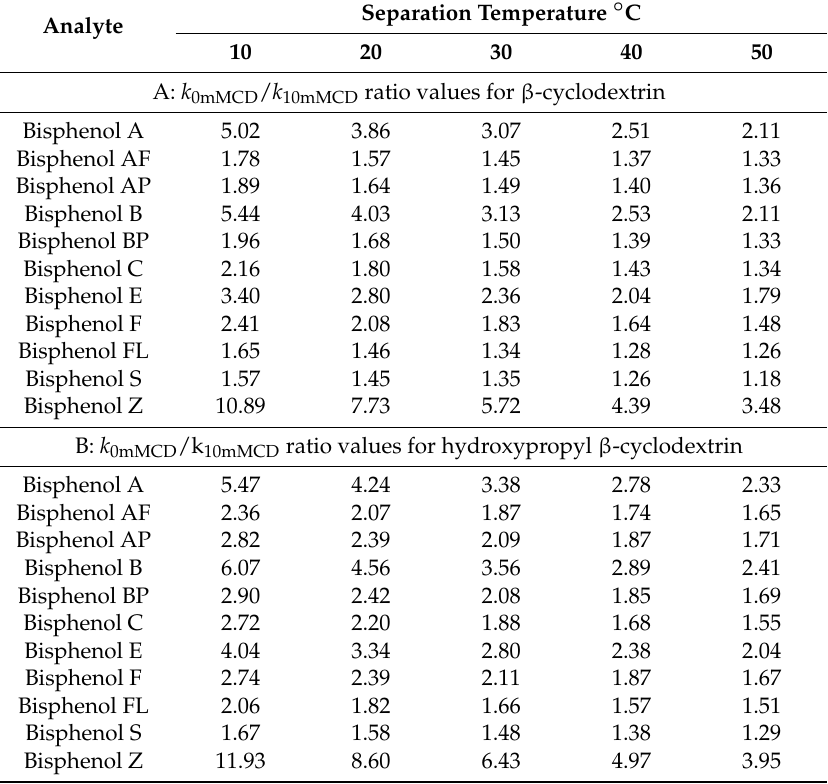
Table 3. Retention factor ratios ( k 0mMCD / k 10mMCD ) reflecting host-guest interaction intensity calculated from data presented in Table 3 for β -cyclodextrin ( A ) and 2-hydroxypropyl- β -cyclodextrin ( B ); Target components highlighted in red were selected for degradation experiment with duckweed under different conditions (Chapter 4.3.2.3) .